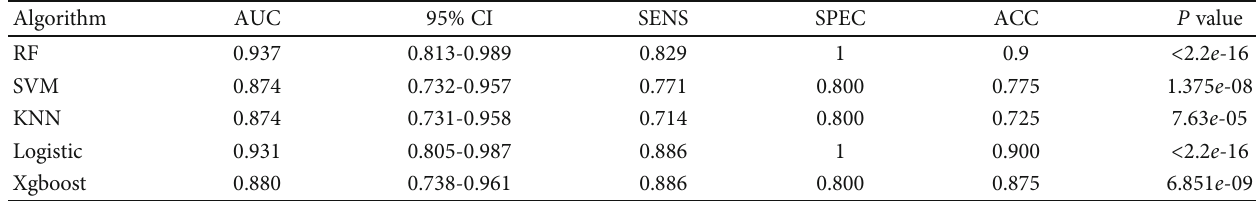
Table 4: A summary of the AUC with di ff erent machine learning methods on the independent test dataset. Algorithm